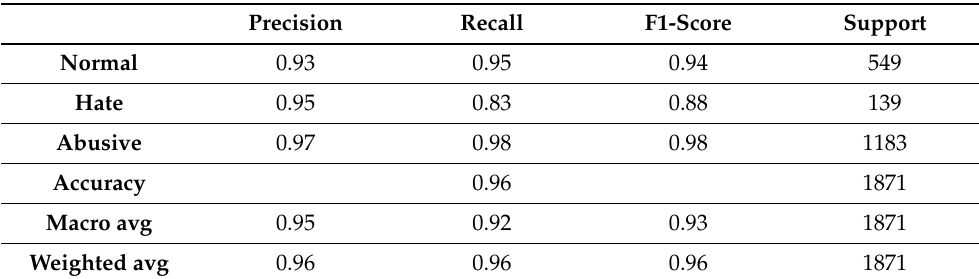
Table 4. The classification report for Linear SVC. Precision Recall F1-Score Support Normal 0.93 0.95 0.94